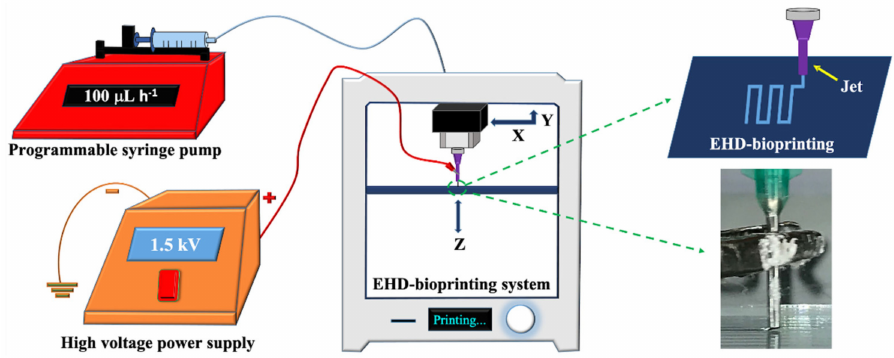
Figure 1. Experimental EHD-3D printing setup with a closer view of the EHD-3D